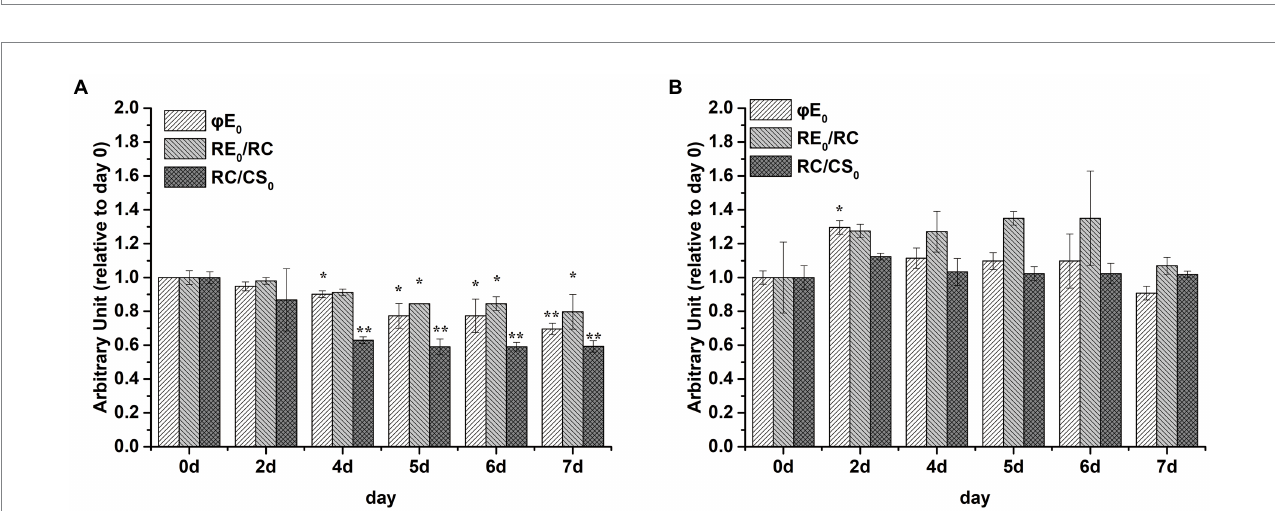
FIGURE 5 Photosynthetic parameters (relative to day 0) derived by the JIP-test of S . costatum (A) and P . globosa (B) under P-limited condition. φ E 0 = ET 0 /ABS = (F v / F m ) × (1 – V J ), which is the quantum yield of electron transport to intersystem electron acceptors at t = 0; RE 0 /RC = (RE 0 /ET 0 ) – (ET 0 /RC), denoting the reduction in end acceptors on the PSI electron acceptor side per RC at t = 0; RC/CS 0 = φ P 0 × (ABS/CS 0 ) × (V J /M 0 ), reflecting the amount of active PSII RCs per CS at t = 0. Error bars are mean ± standard error (SE) of triplicate treatments. Superscripts indicate significant differences between +P group and − P group according to a two-way ANOVA with a post-hoc test (** p < 0.01, * p <